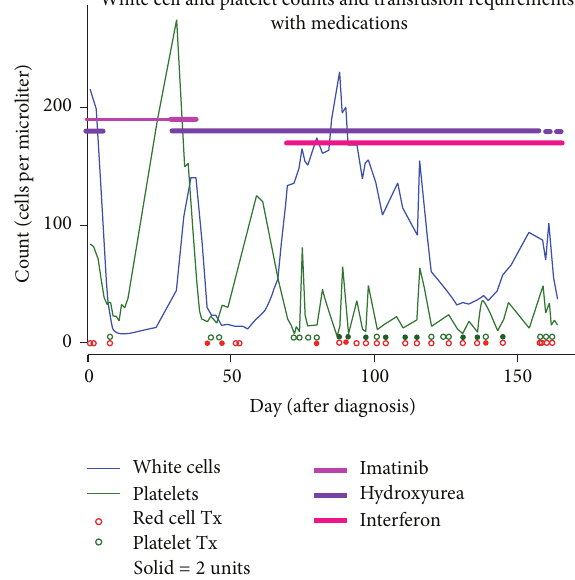
Figure 2: Summary of clinical course. The “Solid = 2 units” refers to the “Red cell Tx” and the “Platelet Tx.” If the red circle is solid, this indicates that 2 units of red cells were transfused. If the green circle is solid, this indicates that 2 units of platelets were